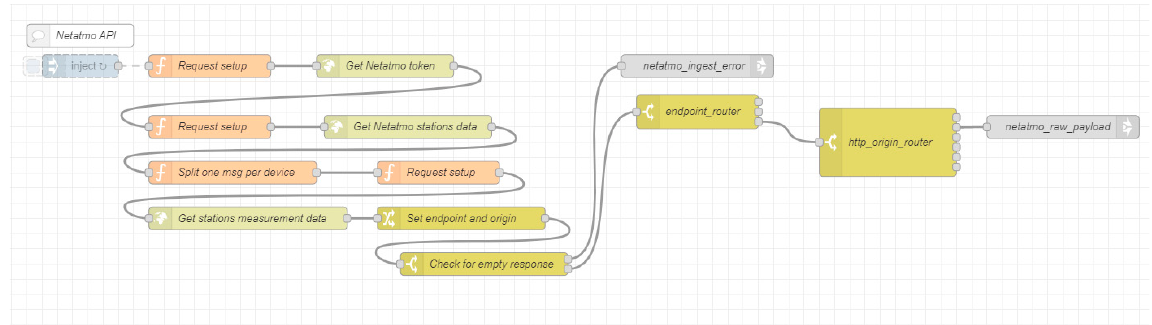
Figure 6. Node-RED flow—Raw data ingest of the Netatmo weather station.